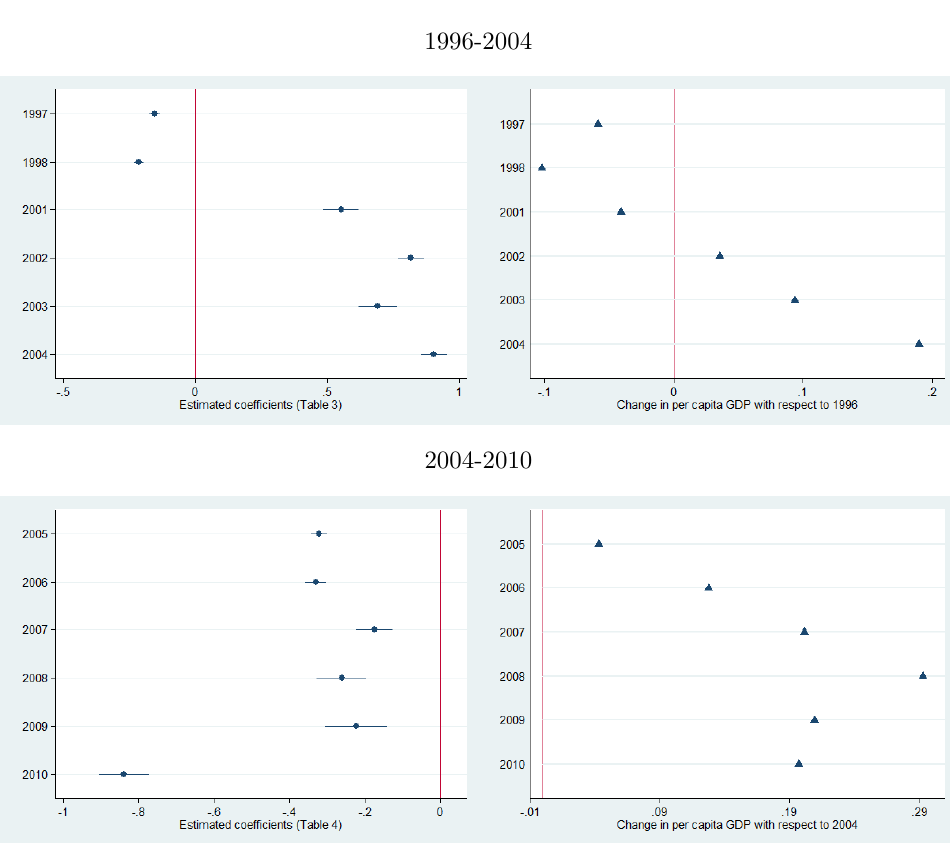
Figure 3: Estimated coefficients and change in per capita GDP over time Source: authors’ own